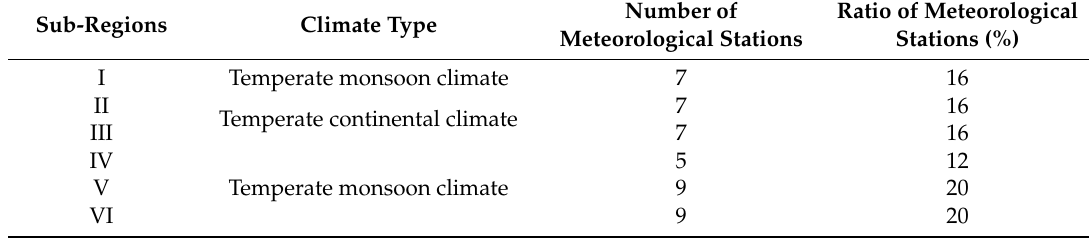
Table 1. Basic information for the sub-regions of the HRB.